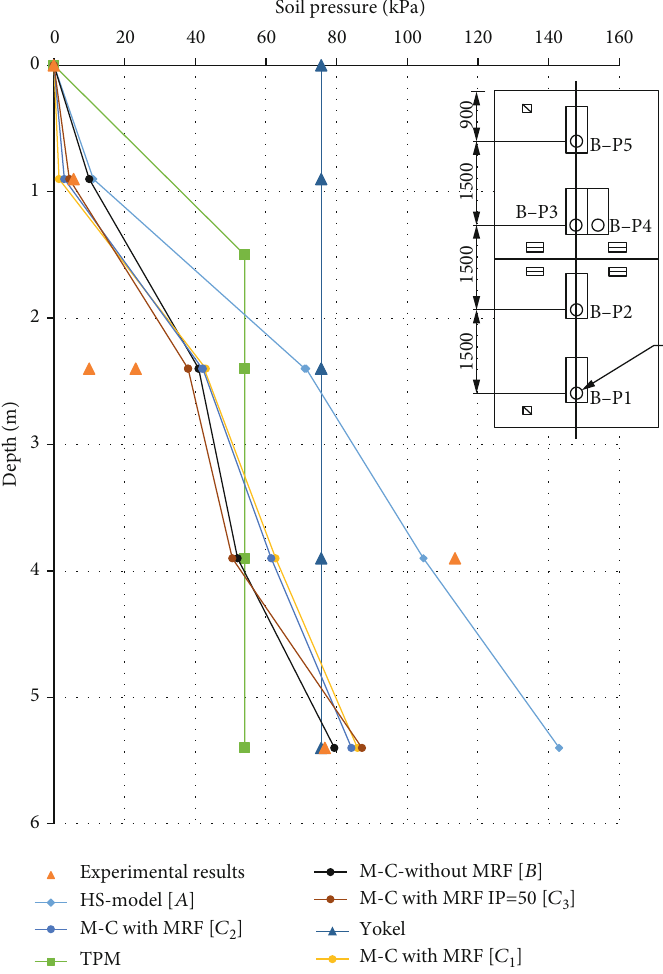
Figure 12: Maximum soil pressure vs. trench depth for di ff erent options of